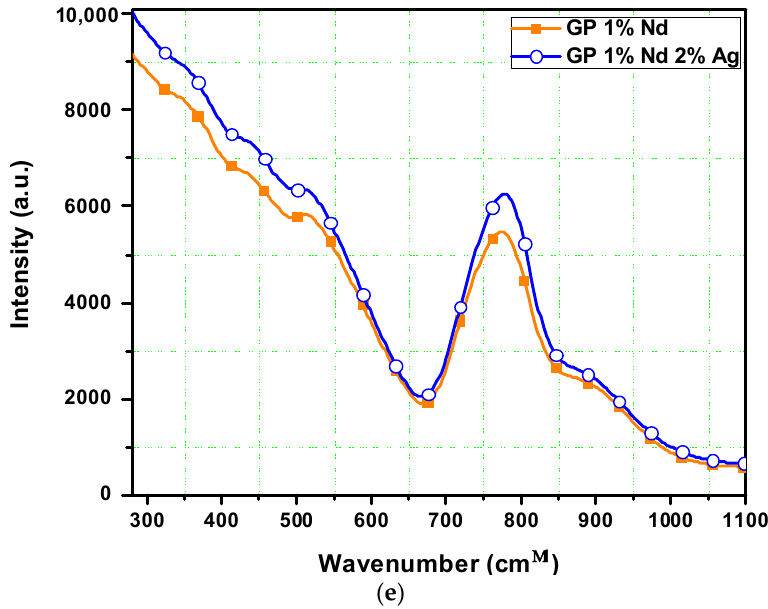
Figure 4. Raman results of Nd 3+ -doped Ge 2 O-PbO glass with Ag NPs in ( a ) the bulk area and ( b ) between the double waveguide written with 4 superimposed lines; Raman results inside the fs written lines of the double waveguide with ( c ) 4 superimposed lines and ( d ) 8 superimposed lines; and ( e ) Raman results in the bulk area of Nd 3+ -doped Ge 2 O-PbO glass with (open circles) and without (square) Ag NPs.